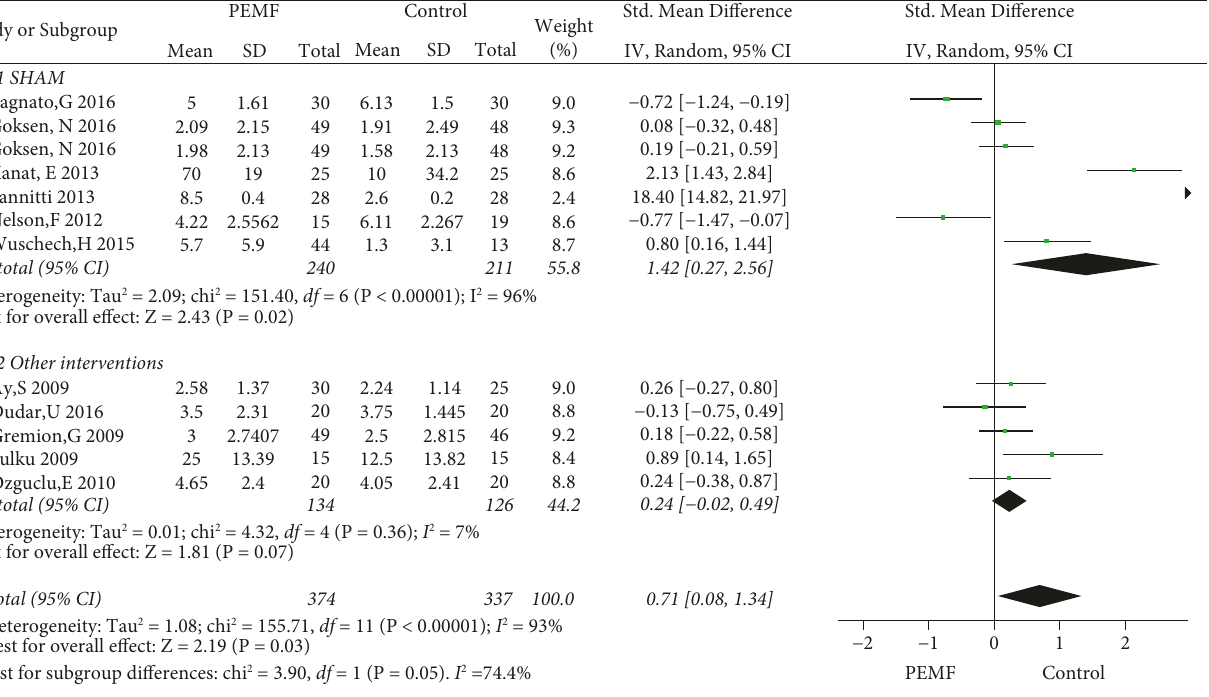
Std. Mean Difference Weight (%)Study or Subgroup IV, Random, 95% CI